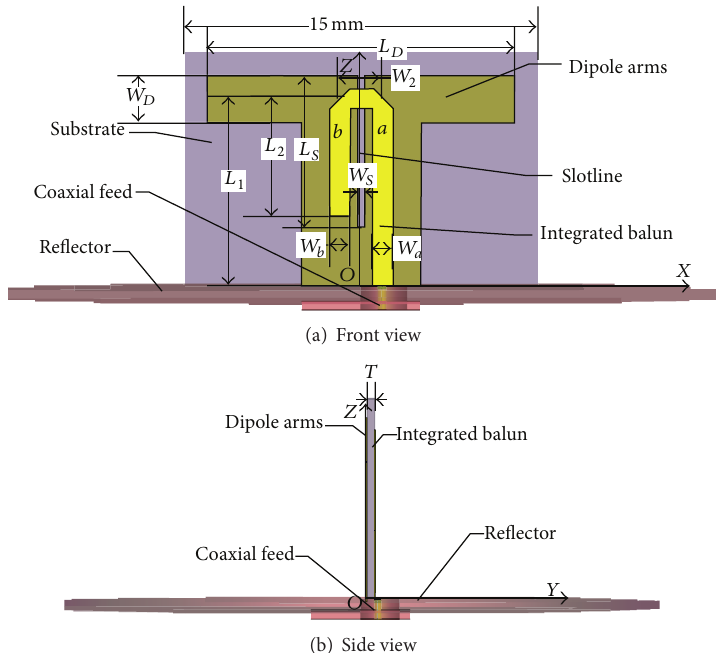
Figure 1: Geometry of the microstrip integrated balun-fed PDA.